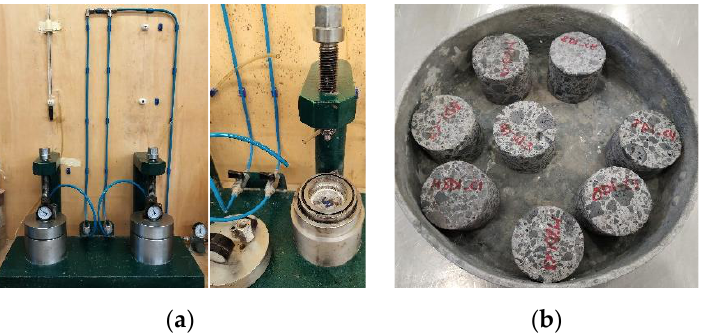
Figure 5. Air and water permeability test set-up: ( a ) Leeds Permeability Cell (LPC); ( b ) specimens used.